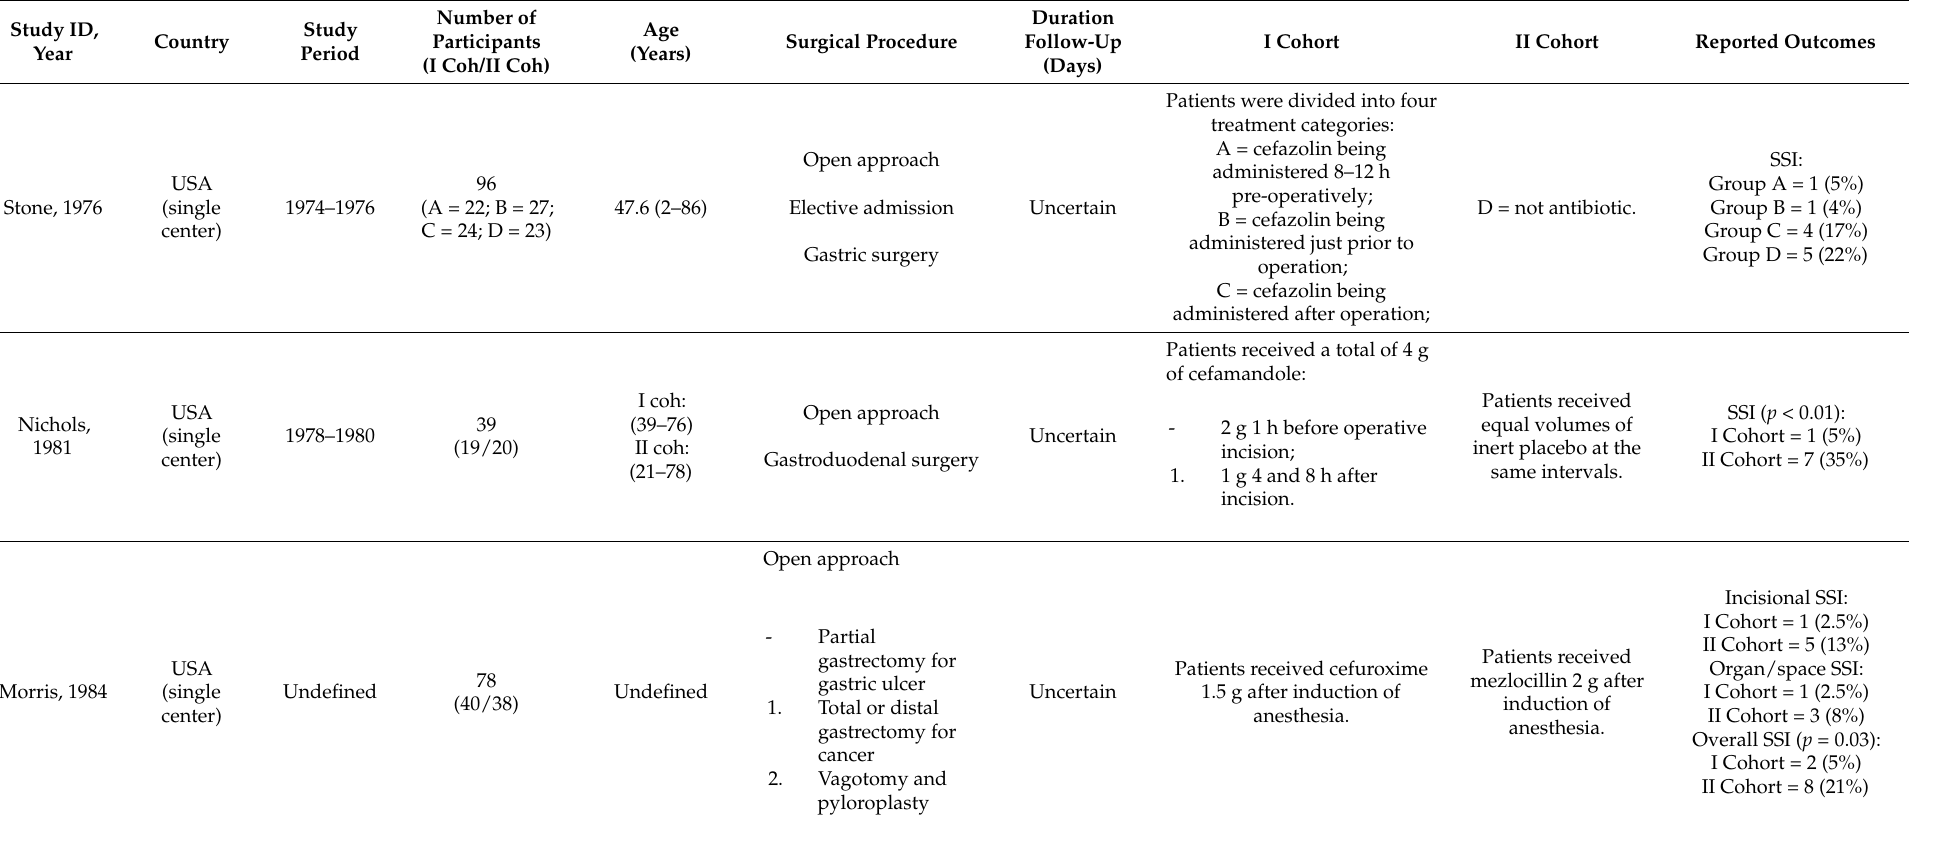
Table 1. Basic characteristics of each study included in this systematic